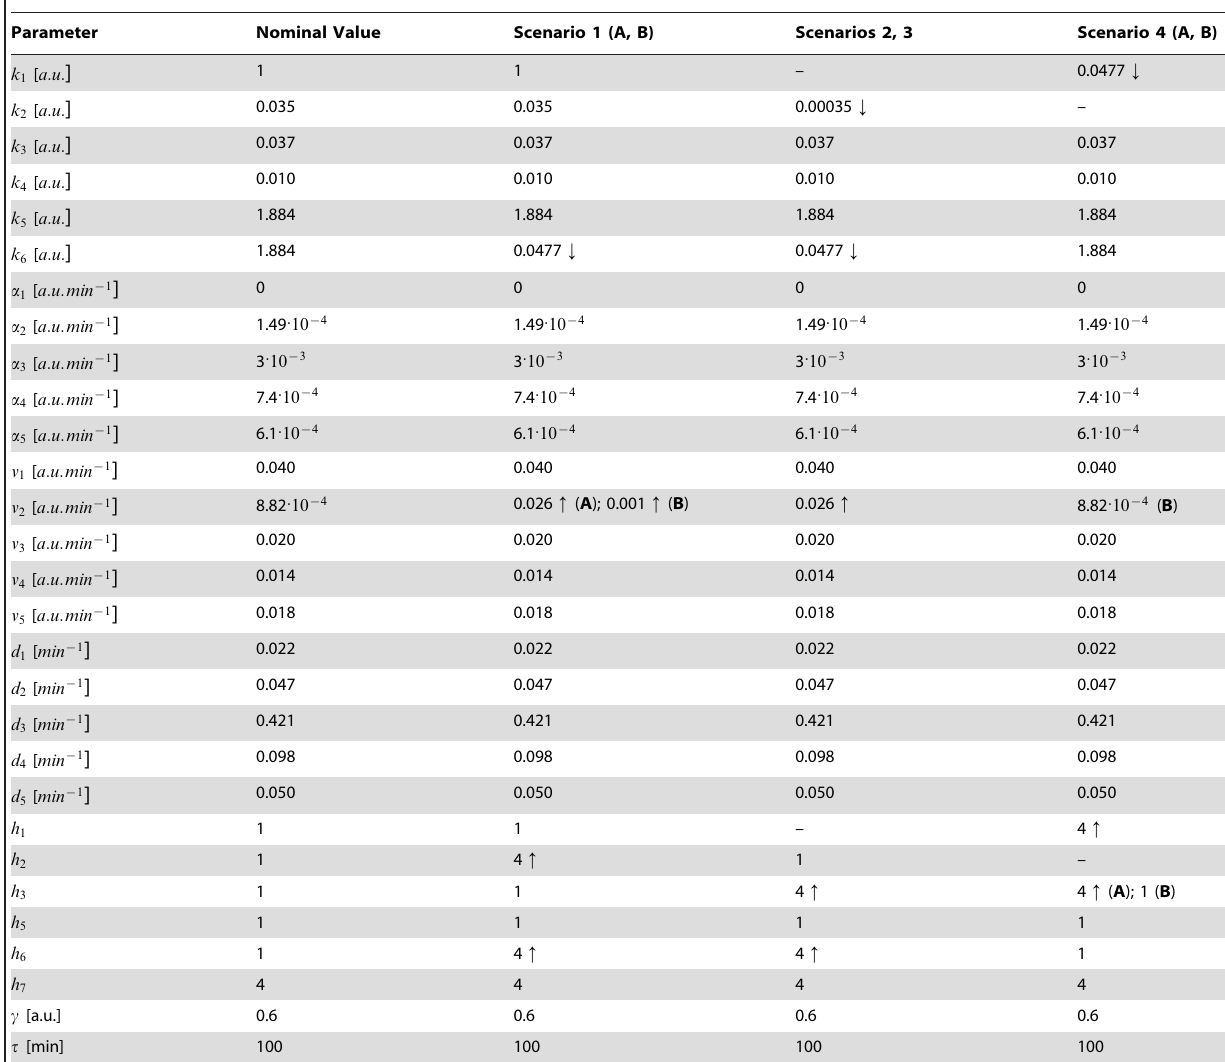
Table 1. Parameters of the mathematical models.